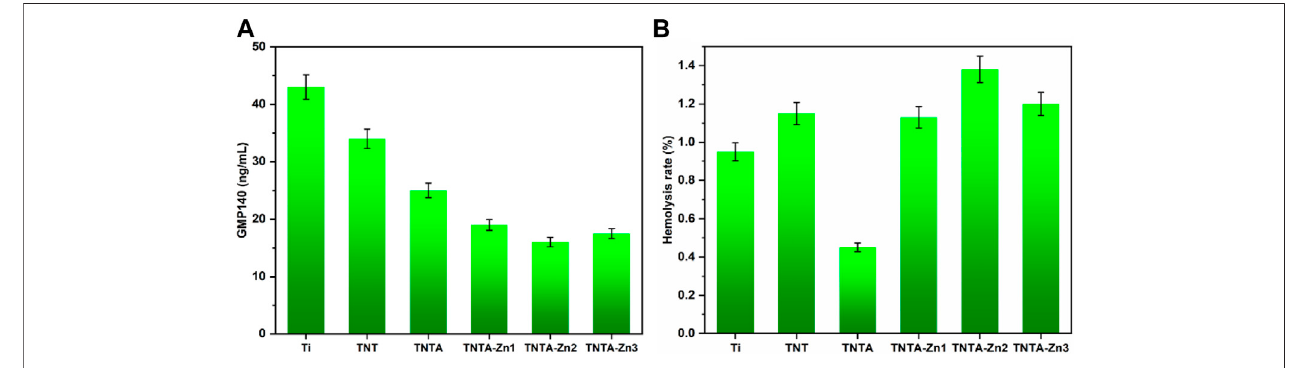
FIGURE 6 | Platelet activation characterized by GMP140 (A) and the hemolysis rate of the different samples (B)